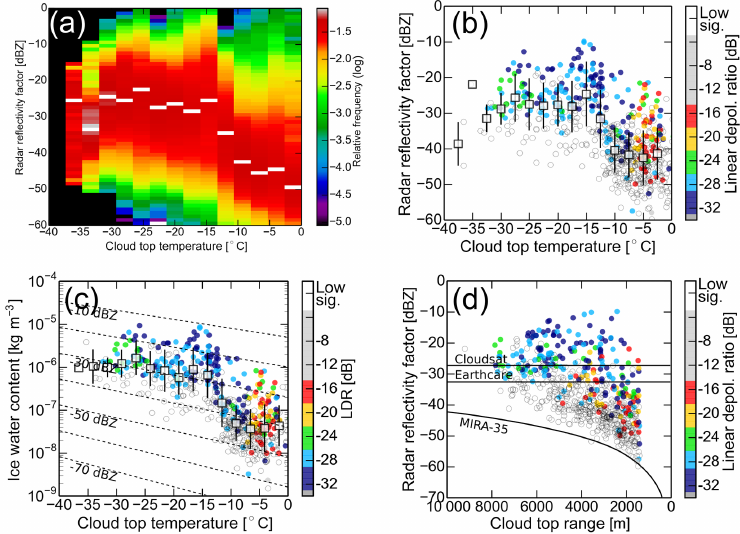
Figure 7. (a) All values of column-normalized Z CB . Maximum values in each column are marked with white bars. (b) Z CB averaged for each cloud case together with averaged LDR values. (c) IWC CB averaged for each cloud case. (d) Values of Z CB depicted depending on CTH instead of CTT; the cutoff at lower heights appears due to the selection criterion CTH > 1500m. Thresholds for Z and IWC are illustrated within the graphs as solid lines with